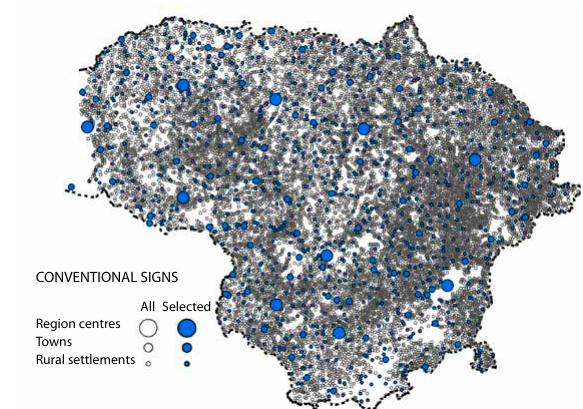
fig. 1. Settlements of lithuania and their selection for the research of spatial